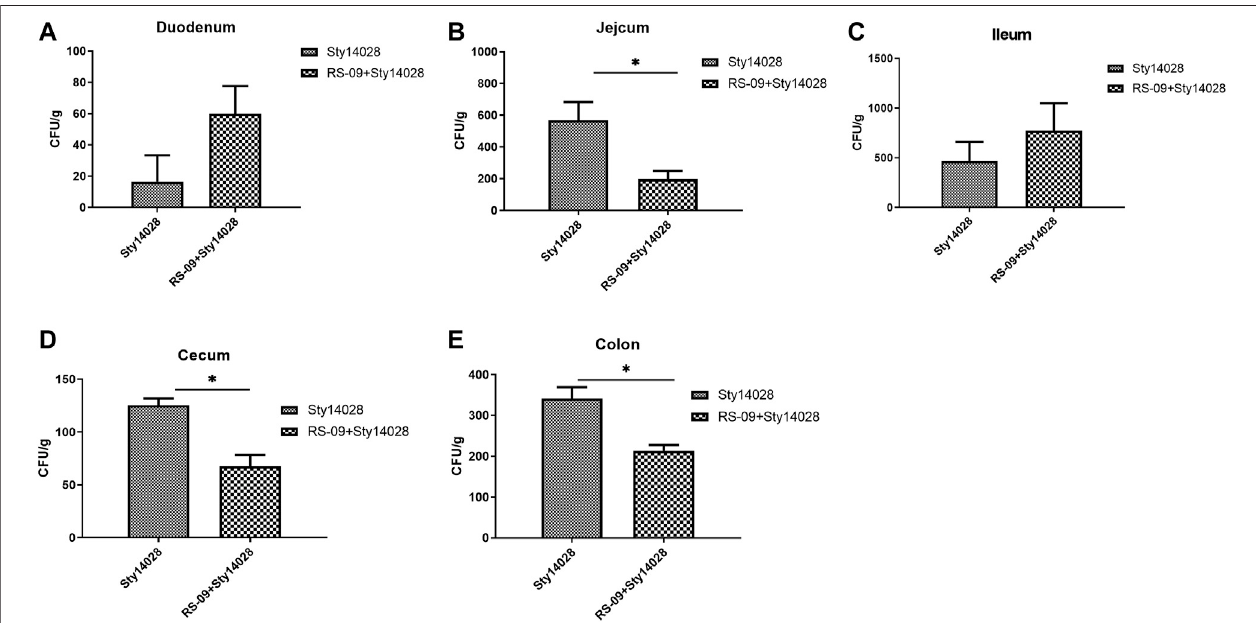
FIGURE 3 | Effect of RS-09 on bacterial load during infection with S . Typhimurium. At the indicated times postinfection, dilutions were plated onto XLT-4 agar plates. (A – E) Sty14028loadsintheduodenum,jejunum,ileum,caecumandcolonfortheSty14028andRS-09+Sty14028groups.Thebactericidalactivityisshownas the surviving bacterial numbers. Data are the means ± SD ( n = 6). * p <